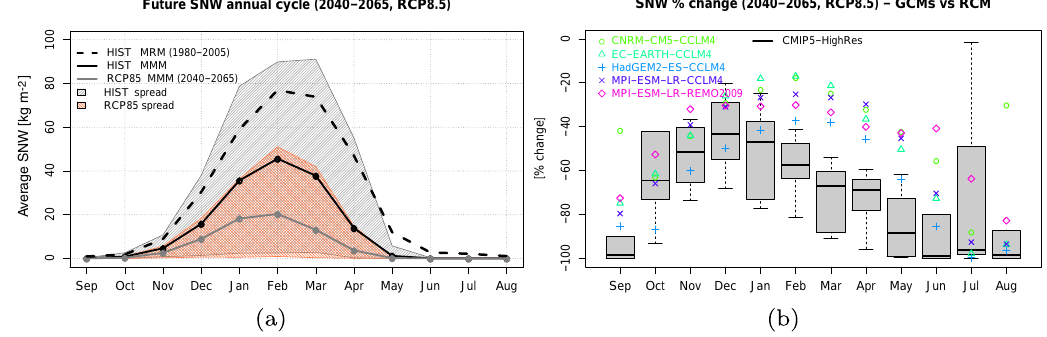
Figure 7. (a) Annual cycle of snow water equivalent expected by the mid-21st century in the RCP8.5 scenario compared to the baseline 1980– 2005, as provided by the high-resolution CMIP5 models. (b) Percent change in snow water equivalent (2040–2065 average with respect to the baseline 1980–2005) as in the high-resolution CMIP5 GCMs (box plot) and RCM